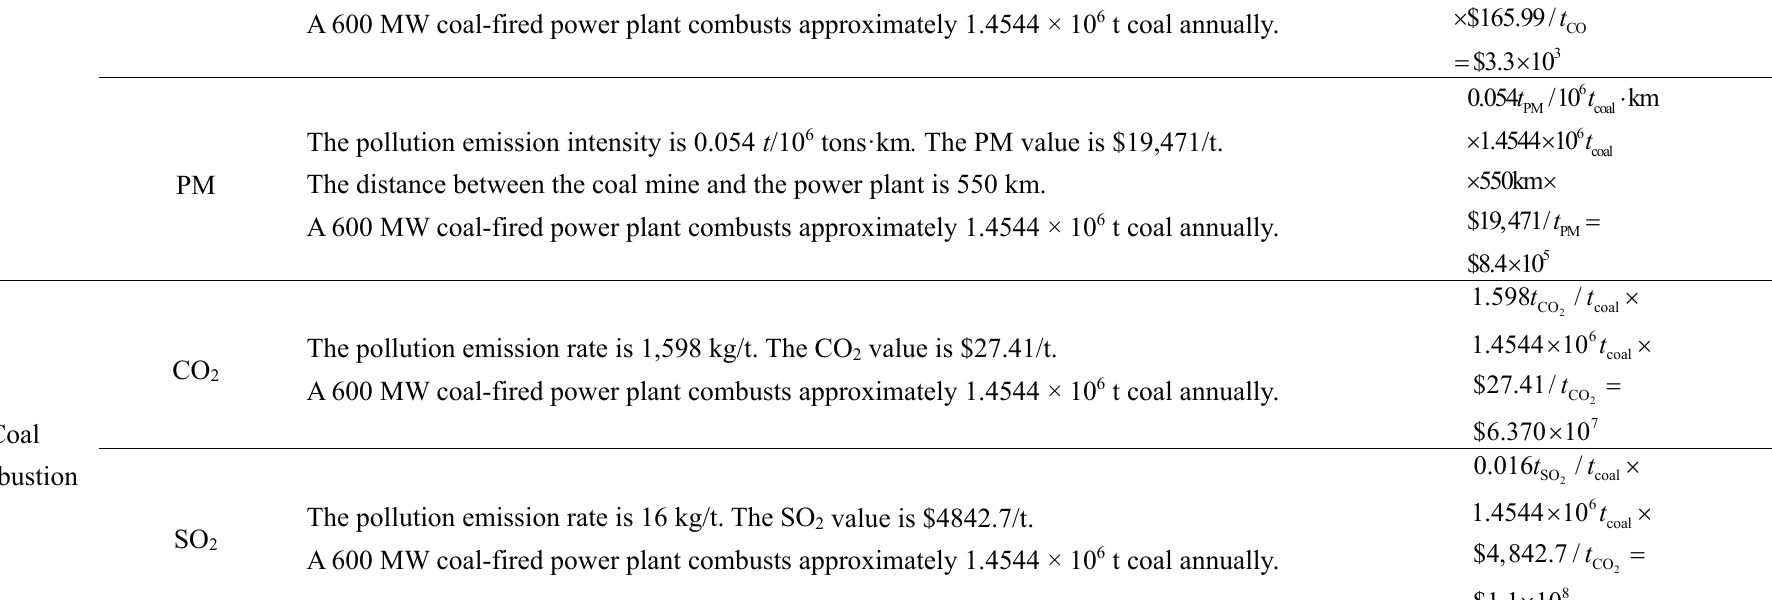
Item Impact Data